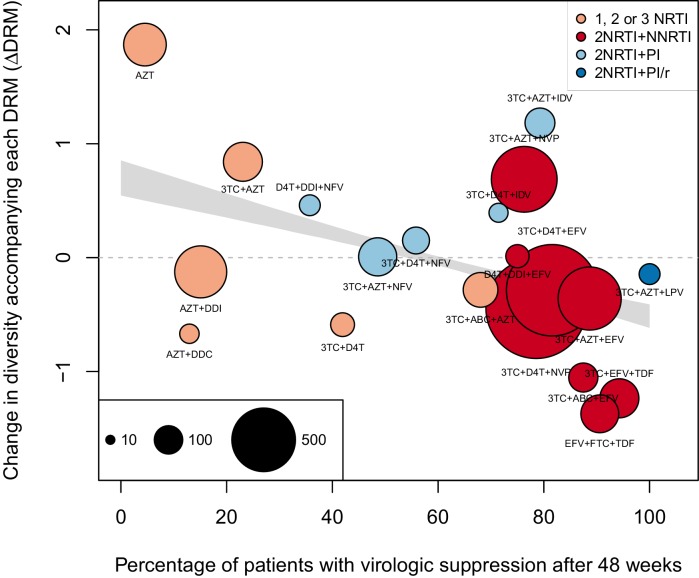
Nonparametric test shows negative correlation between treatment effectiveness and ΔD⁢R⁢M when sequences with any number of DRMs are included.This figure is analogous with Figure 4 from the main text, but in this case, the data is not truncated to only include the patients with 4 or fewer DRMs. The D⁢e⁢l⁢t⁢aD⁢R⁢M coefficients are taken from the GLMM shown in Figure 3—figure supplement 2A and B. The figure caption is otherwise shared with Figure 4.